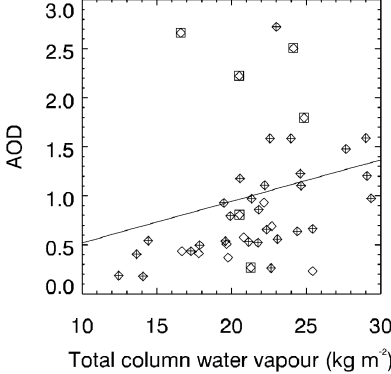
Figure 1. Daily means of TCWV and AOD, pluses show days with complete surface data, squares show days with some interpolation (see Sect. 2). Diamonds show all data points (including days with no surface-flux